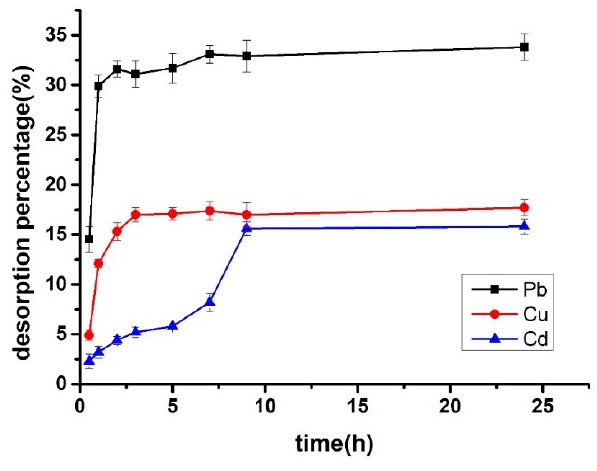
2 + , Cu 2 + , and Cu 2 + from SPM after successive Figure 8. The desorption behaviors of Pb 2+ , Cu 2+ , and Cu 2+ from SPM after successive desorption. Figure 8. The desorption behaviors of Pb